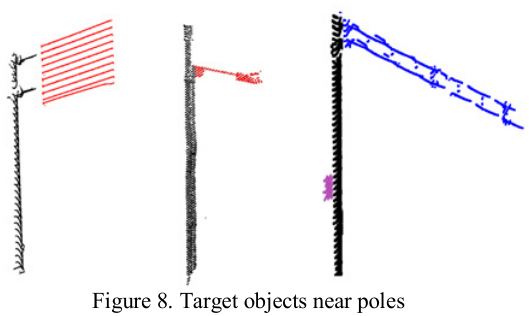
Figure 8. Target objects near poles